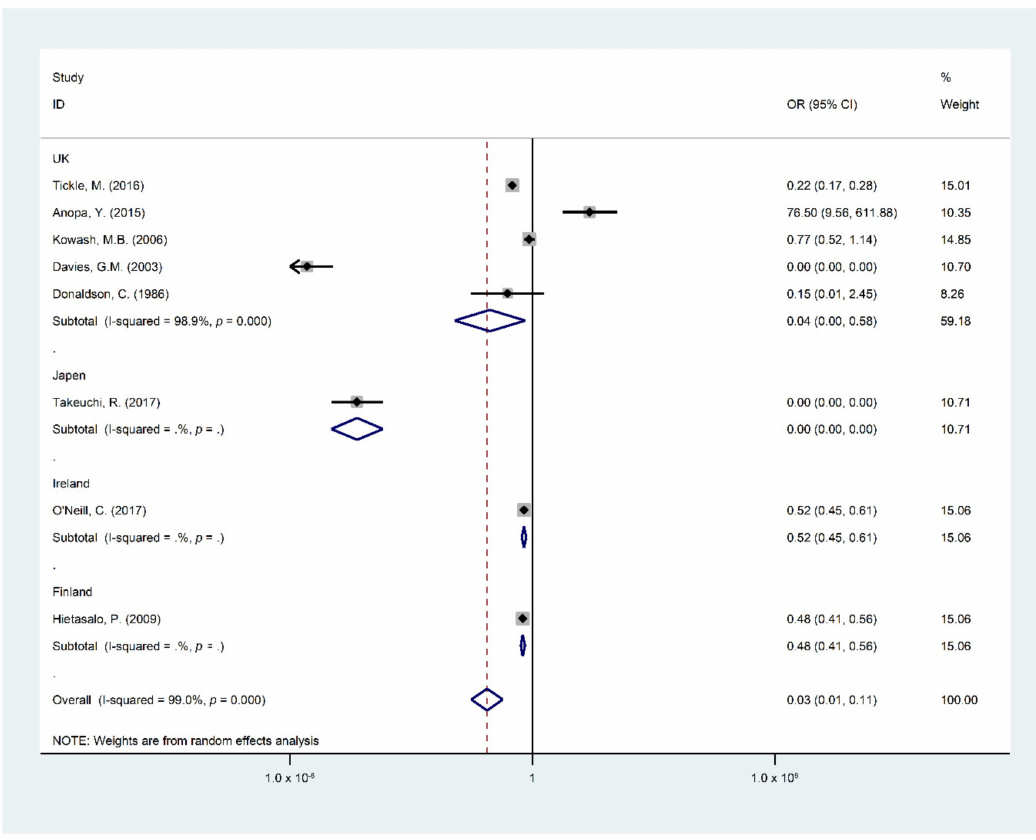
Figure 7. Forest plot for the di ff erence in the DMFT / S of the intervention group compared to the control group by study